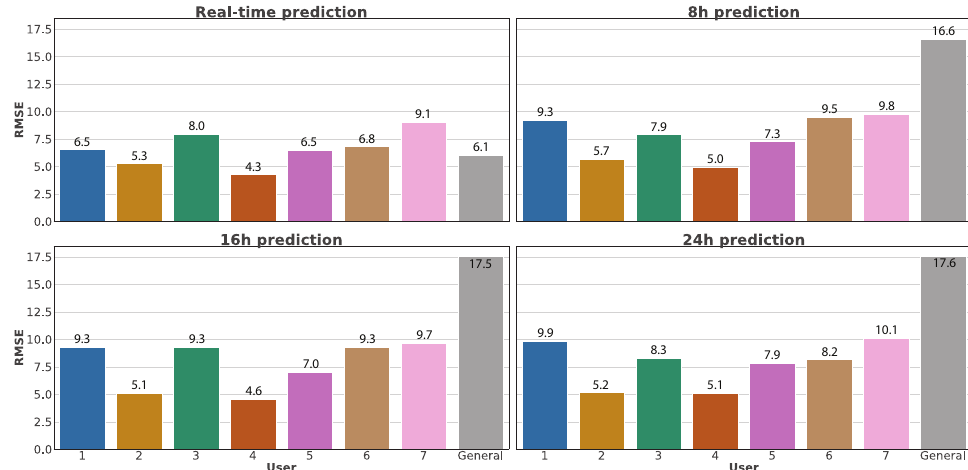
Figure 16. Comparison between real-time and future predictions using Random